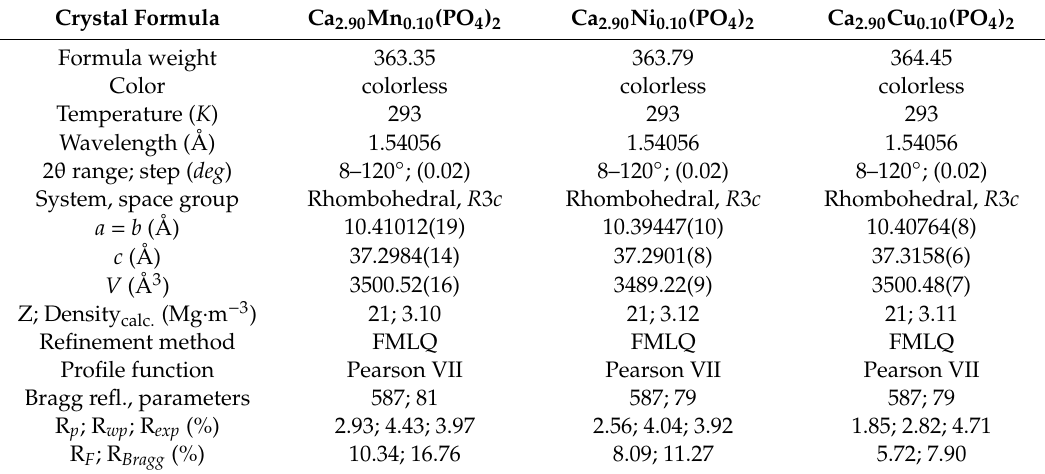
Table1. MainacquisitionandstructurerefinementparametersforMe β -Ca 3 (PO 4 ) 2 tricalciumphosphate ( β –TCP) (FMLQ = full matrix least squares; Pearson VII